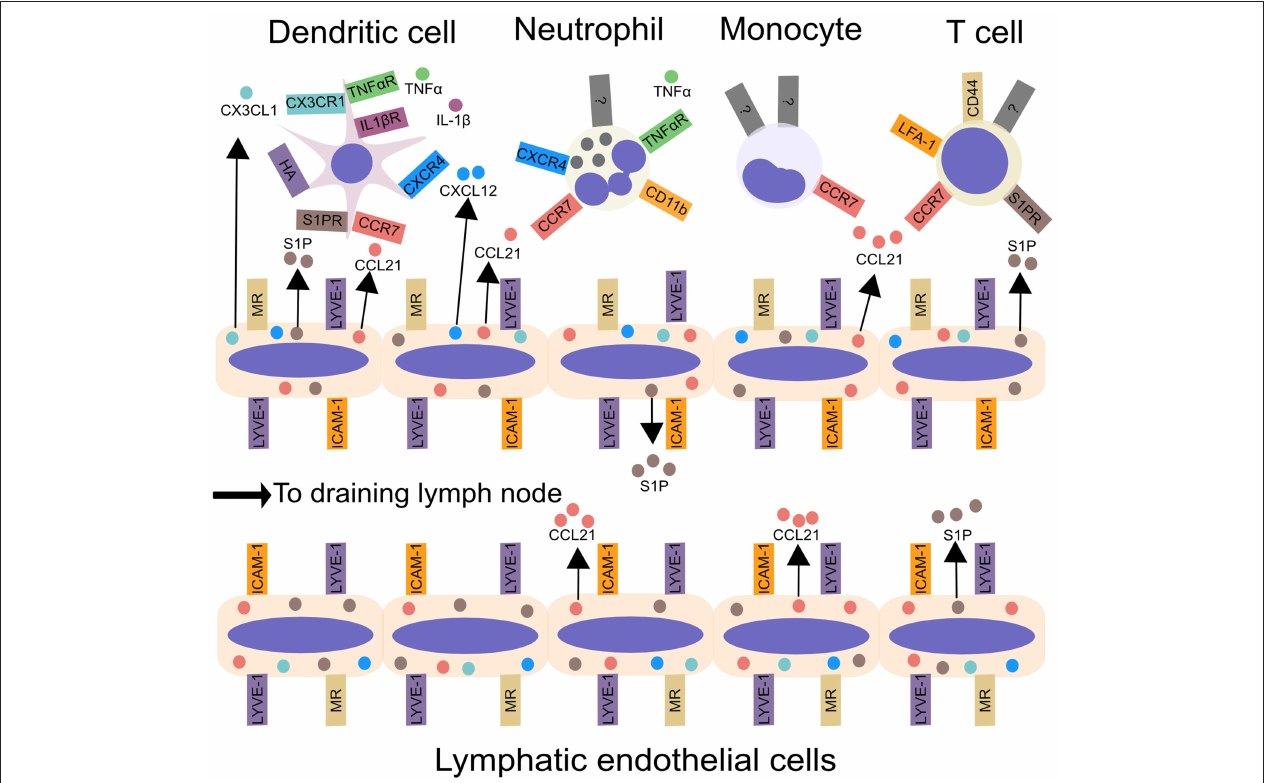
FIGURE 1 | Leukocyte migration from peripheral tissues to draining lymph nodes via afferent lymphatic vessels. Inflammatory cytokines, including IL-1 β and TNF- α , produced by tissue-resident myeloid cells, enhance DC and neutrophil migration from tissues to lymphatic vessels. Chemokines, such as CCL21, CX3CL1, and CXCL12, synthesized by LECs in the skin control leukocyte migration to lymphatic vessels and aid transmigration into the vessel lumen. In addition to chemokines, lymphatic endothelial cells produce the lipid S1P, which acts upon S1P receptors, to promote the migration of DCs and T cells into lymphatic vessels and aid trafficking to the draining lymph node. Integrins, such as ICAM-1, CD11b, and LFA-1 may promote leukocyte entry into lymphatic vessels and subsequent migration within lymphatics. Interactions between CD44 and MR promote T cell entry into lymphatic vessels. Lastly, LYVE-1 can bind to hyaluronic acid on DCs, and promote DC entry into lymphatic vessels. ICAM-1, Intercellular Adhesion Molecule 1; LFA-1, lymphocyte function-associated antigen 1; LYVE-1, Lymphatic vessel endothelial hyaluronan receptor 1; MR, macrophage mannose receptor; S1P,